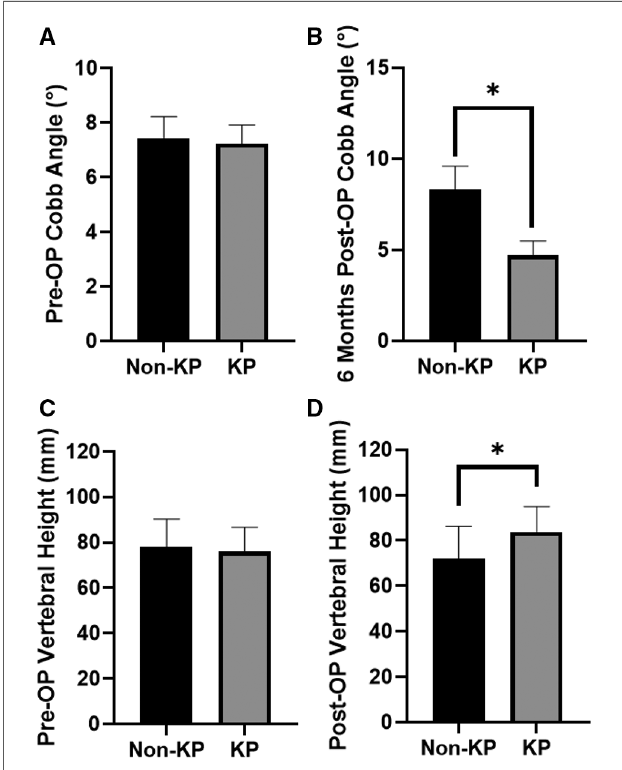
FIGURE 3 Cobb angle. ( A ) Before KP operation. ( B ) Six months after KP operation. Anterior height of vertebrates. ( C ) Before KP operation. ( D ) Six months after KP operation ( *p